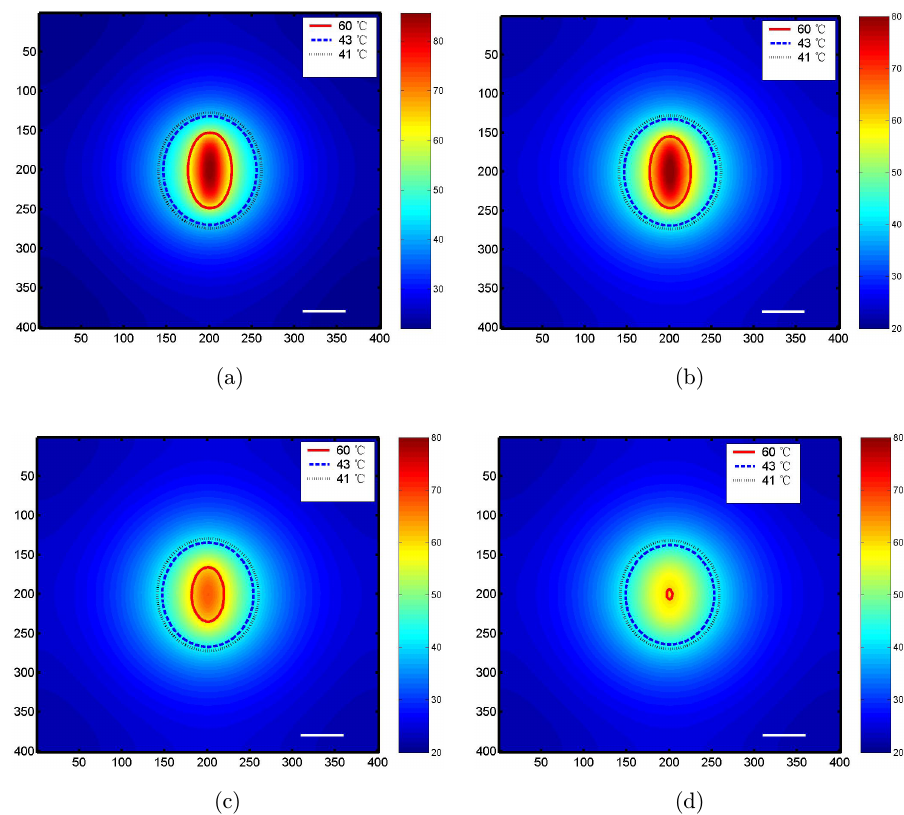
Fig. 7. (a) x – y temperature image at di®erent z depths of (a) 0 mm, (b) 0.5 mm, (c) 1.5 mm and (d) 2.5 mm. Scale bar ¼ 5